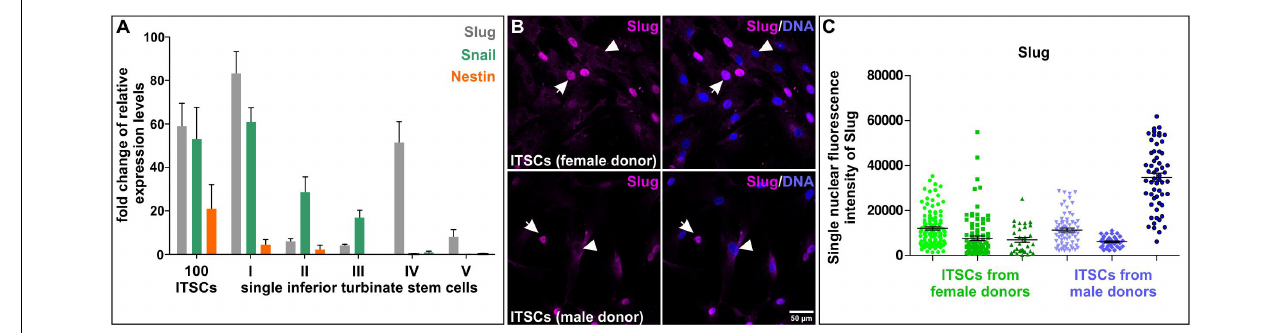
FIGURE 4 | Heterogeneity of single neural crest-derived inferior turbinate stem cells (ITSCs) isolated from the human nasal cavity. (A) qPCR following SMART-Seq2 of single ITSCs showed heterogeneity in expression levels of Slug, Snail and Nestin. (B,C) Heterogeneous nuclear fluorescence intensities of Slug protein in single